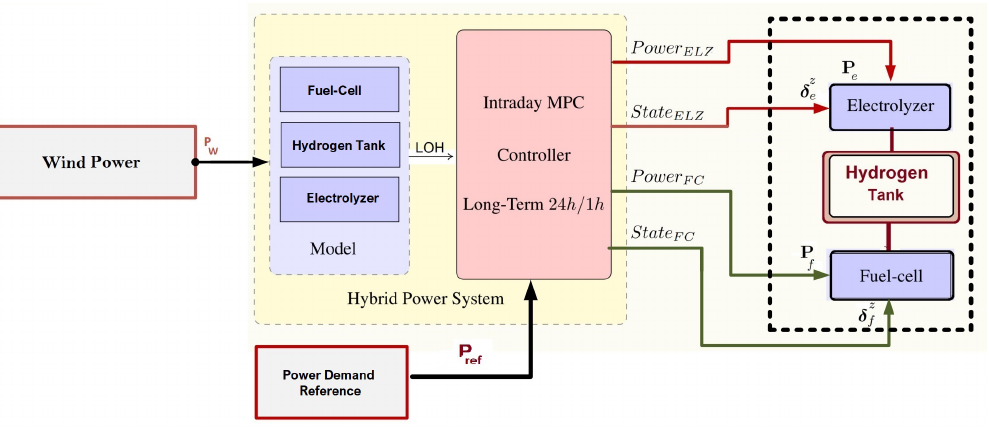
Figure 3. Proposed MPC Control